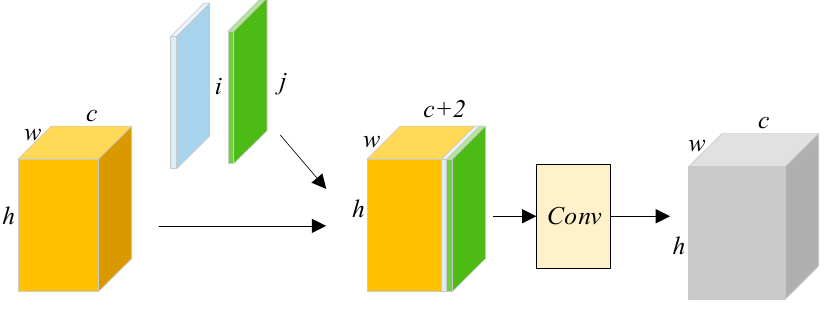
Figure 4. CoordConv module.